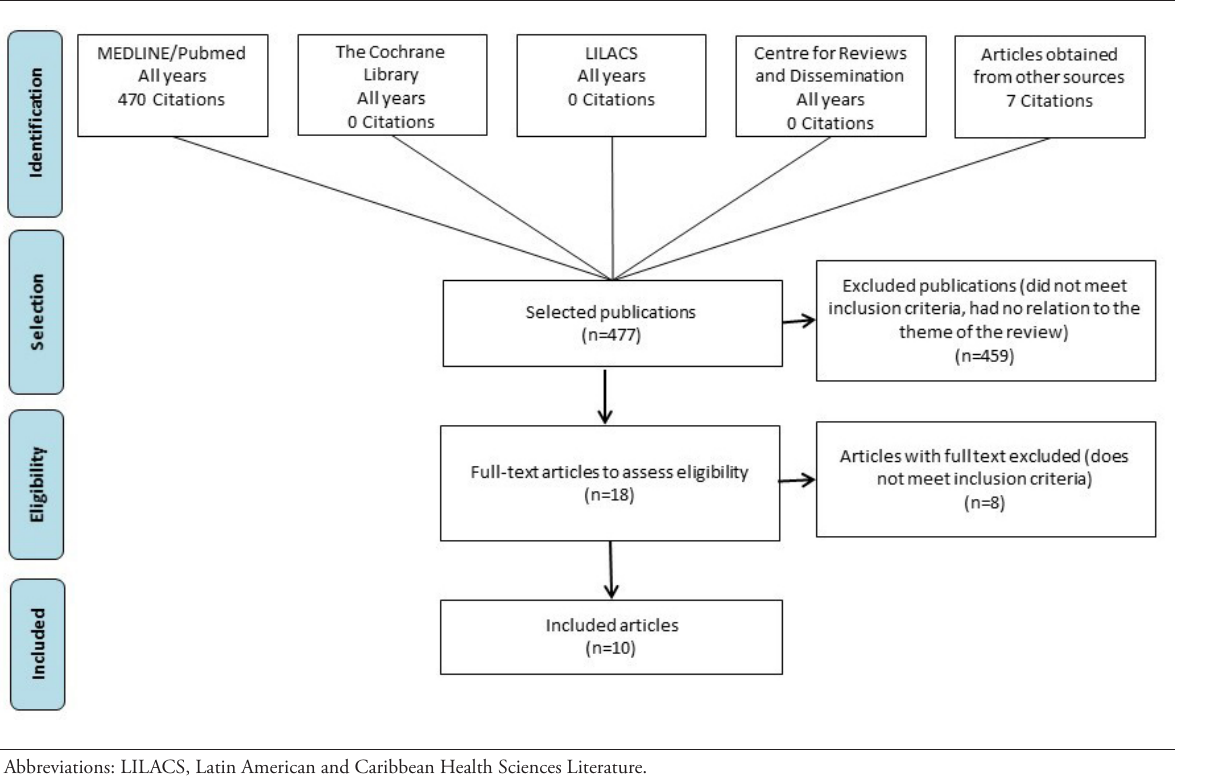
Figure 1. Study Selection Flowchart